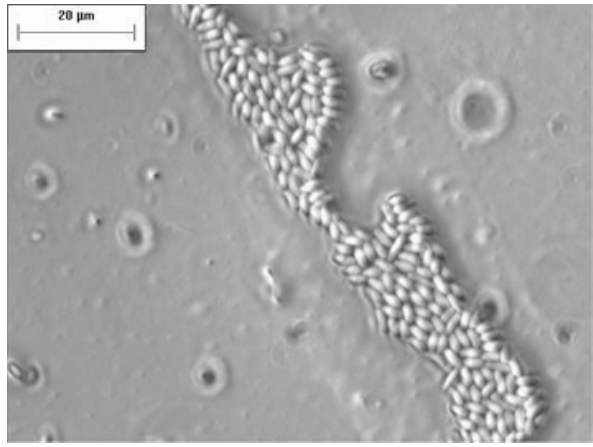
Figure 2. Conidia from Plenodomus biglobosus .